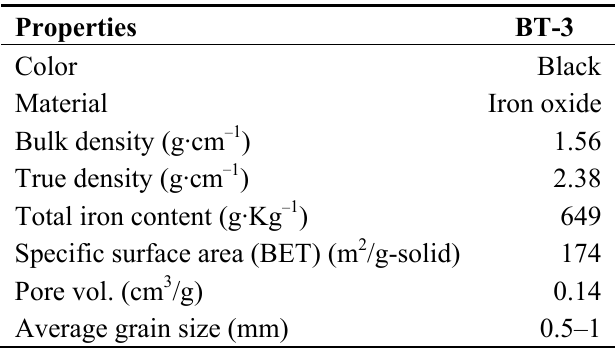
Table 1. Physical properties of